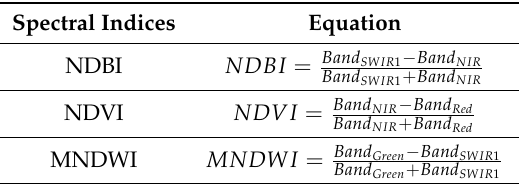
Table 2. Spectral indices selected for our